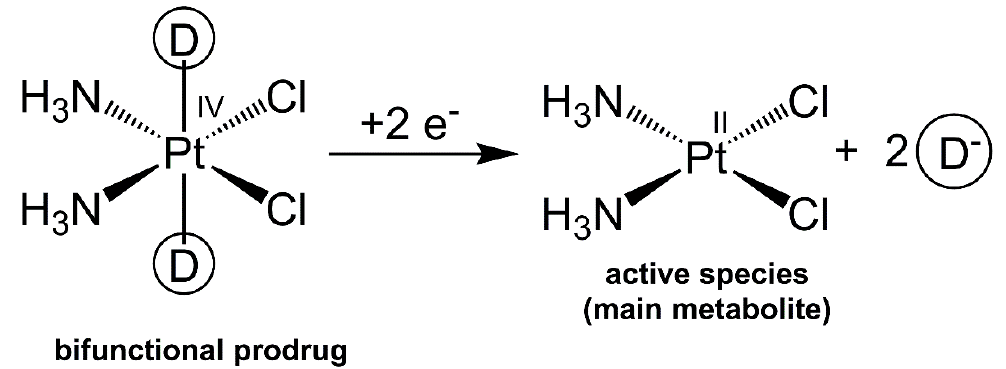
Figure 1. Reduction reaction of a cisplatin-based Pt(IV) prodrug; D = second drug.